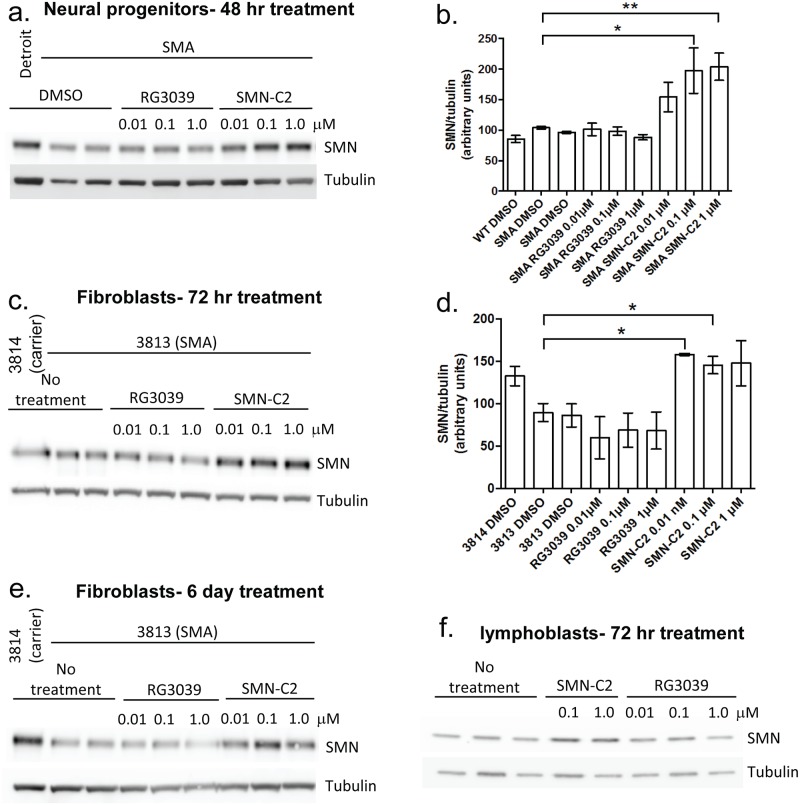
Effect of RG3039 on cellular SMN protein levels determined by Western blot.A. Neural progenitor cells treated for 48 hours (example) and B. quantification of data from 4 independent experiments; C. Fibroblasts treated for 72 hours (example) and D. quantification of data from 3 independent experiments; E. Fibroblasts treated for 6 days (example); F. SMA lymphoblasts treated for 72 hours (example). DMSO final concentration for lymphoblast cells was 0.1% and 0.2% for neural progenitors and fibroblast cell lines. All aggregate data is expressed as mean ± s.e.m. and statistical significance vs. SMA DMSO (B.) or 3813 DMSO controls (D) was assessed using Student’s t-test: P<0.05 (*), P<0.01(**) or otherwise non-significant where not indicated.